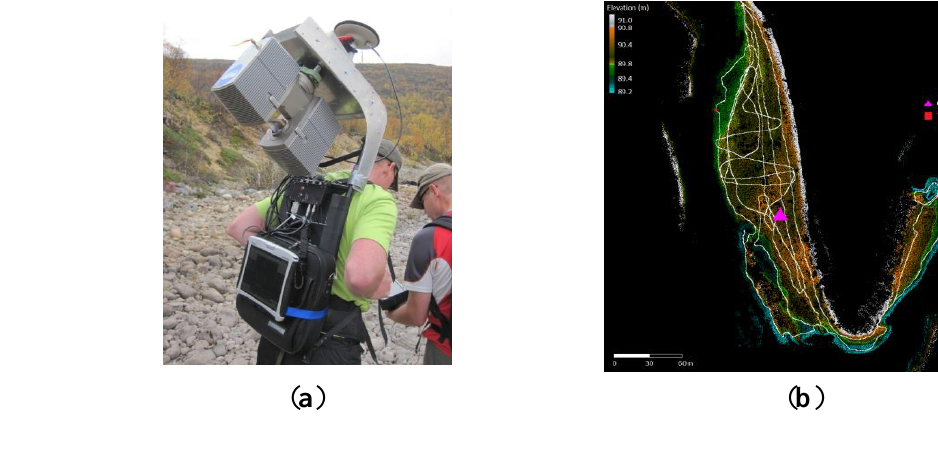
( b ) An overview of the MLS data. Colors of MLS points reflect the elevation. Purple lines represent the scanning track. Reference spheres are marked with yellow circles. The center of the dataset (ETRS-TM35FIN (501303.67, 7755162.81)) is marked with a pink triangle. The location of the experimental data is marked with a red square (upper right to the study site)